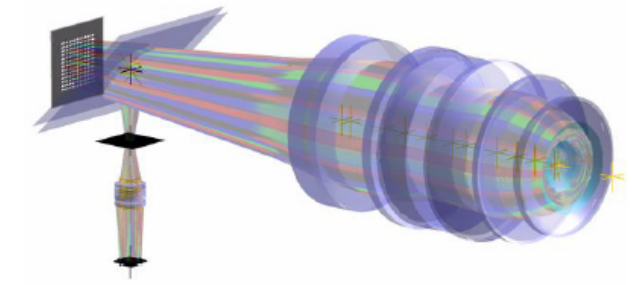
Figure 1. Schematic of the tilted-wave interferometer (reference arm not shown). The 2D point source array is on the left, the speci- men is on the right, and the CCD is at the